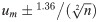
Goodness-of-fit assessment (K-S plot) of proposed model.If the model describes the data well, the estimated distribution should follow a forty-five degree line. The 95% confidence intervals for the Kolmogorov-Smirnov statistic are computed by um±1.36(n2), where um=(m−12)/n are the values of the cumulative distribution (CDF) of a uniform random variable, m = 1, 2, ⋯, n, and n is the number of interspike intervals. Results show that the Poisson model does not describe the data well.